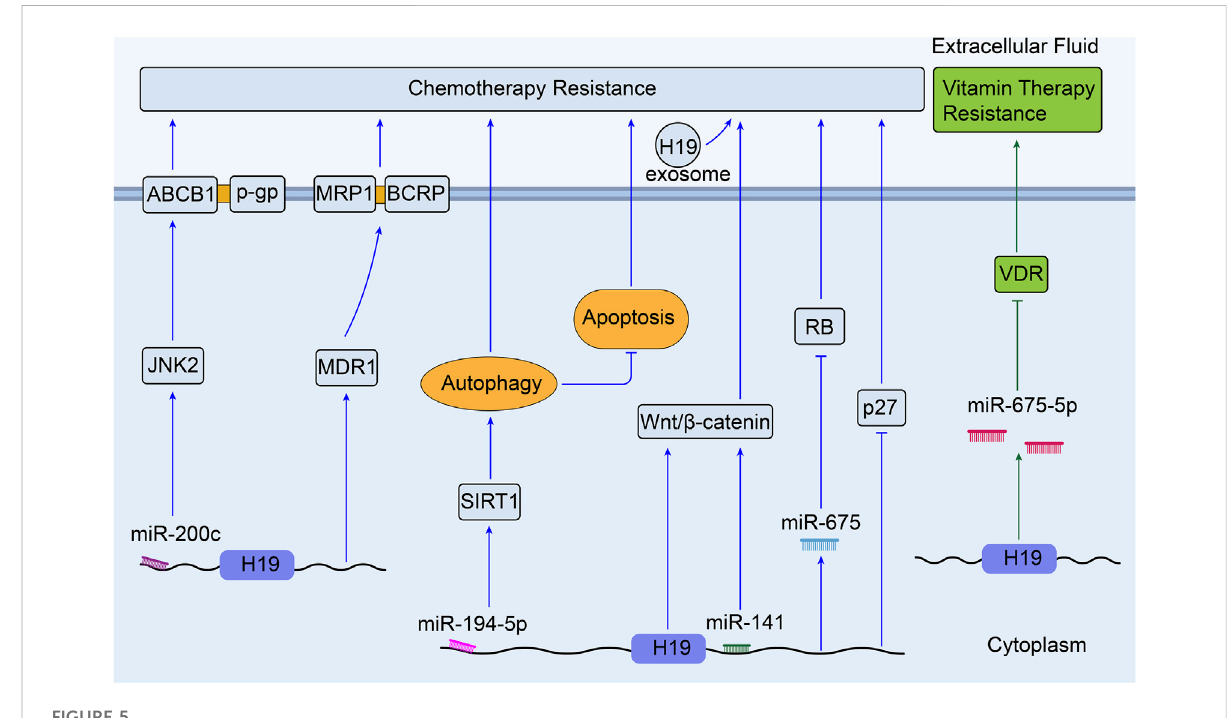
FIGURE 5 Overview of the role of H19 in modulating colorectal cancer therapy